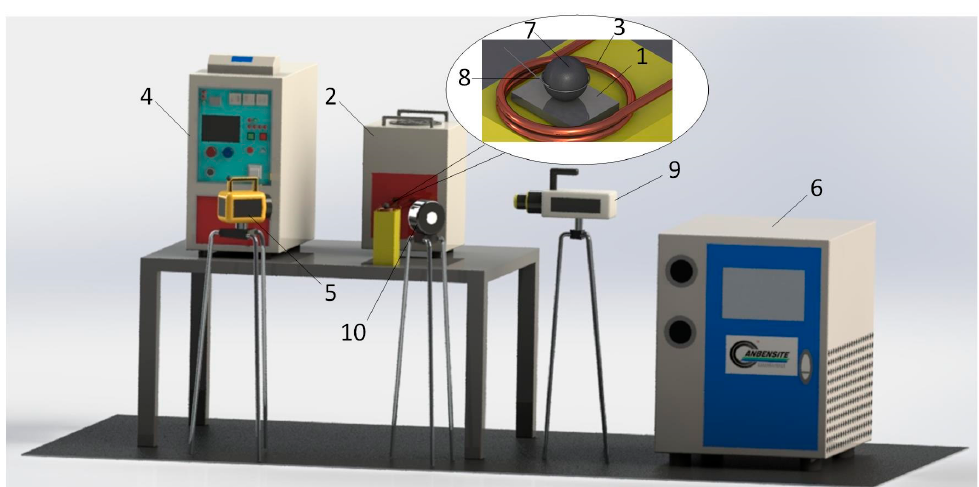
Figure 4. Experimental setup of a conductive heat supply to a fuel droplet. 1—modified steel surface; 2—electromagnetic inductor; 3—induction spiral; 4—control unit for inductor; 5—thermal imaging camera; 6—chiller; 7—fuel droplet; 8—holder; 9—high-speed video camera; and 10—spotlight.